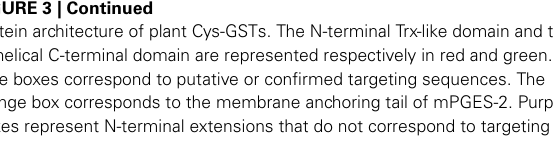
sequences and gray boxes represent additional C-terminal domains. The position of the active site motif harboring the catalytic cysteine is indicated in black. The presence of inserted sequences in some classes corresponds to dashed lines in other classes. Secondary structures are shown as α -helices and β -strands. The size of the boxes is proportional to the length in amino